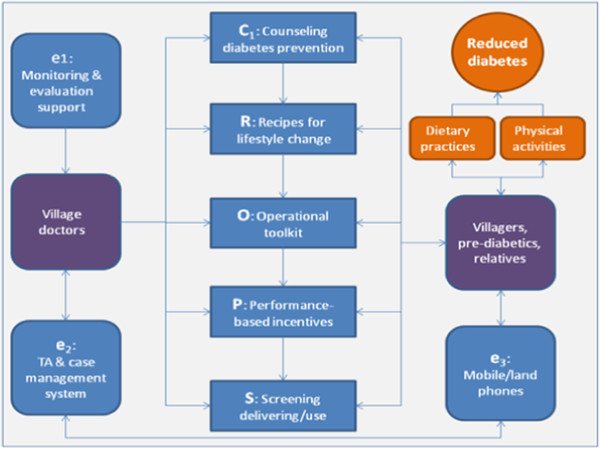
Key components of project intervention (eCROPS).